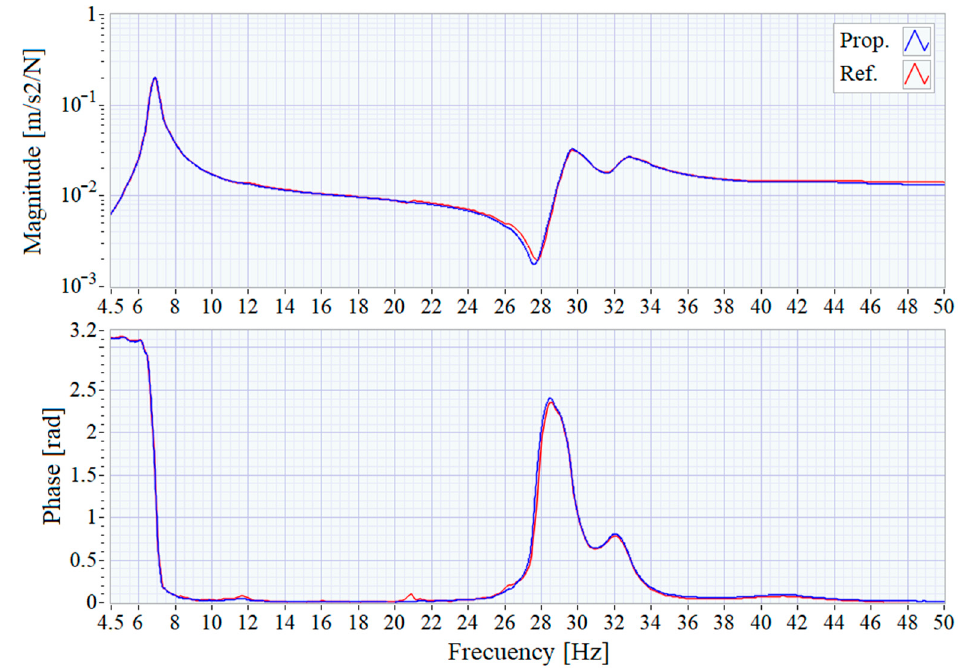
Figure 10. Frequency Response Function from 4.5 to 50 Hz.